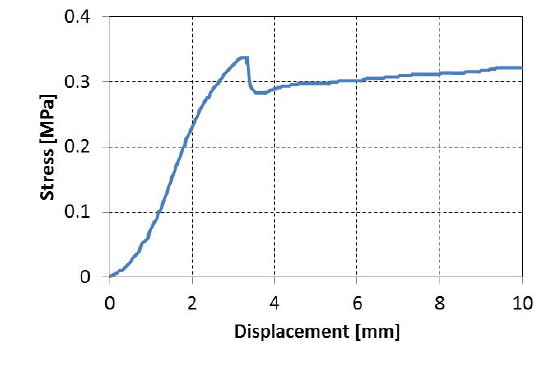
Figure 4. Compressive test of subgrade material.